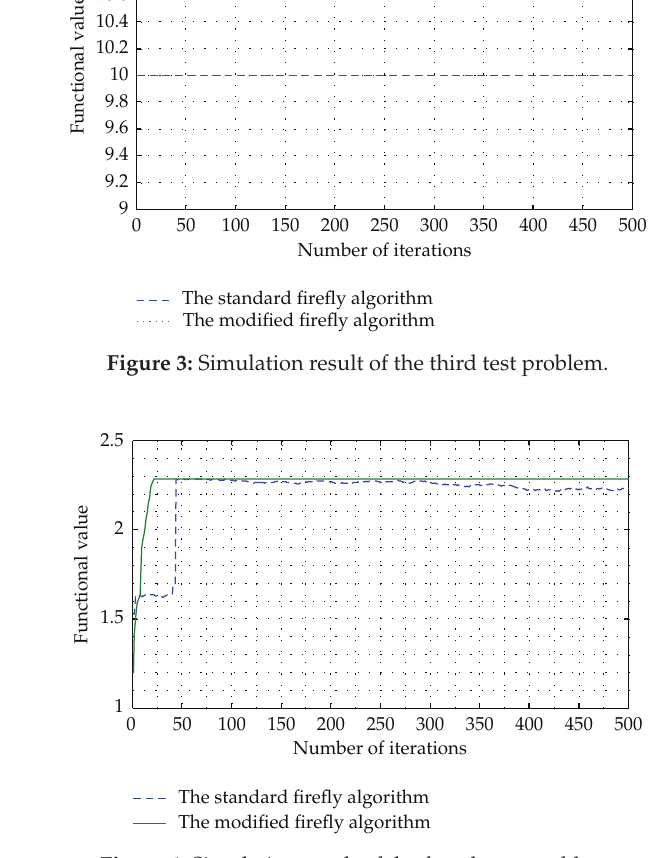
Figure 4: Simulation result of the fourth test